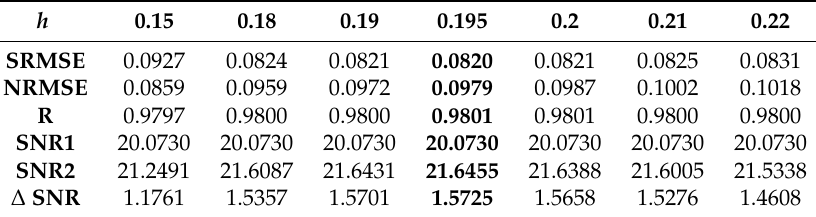
Table 1. Different Gaussian parameters in the non-local means (NLM) algorithm correspond to the results of each indicator (NCE